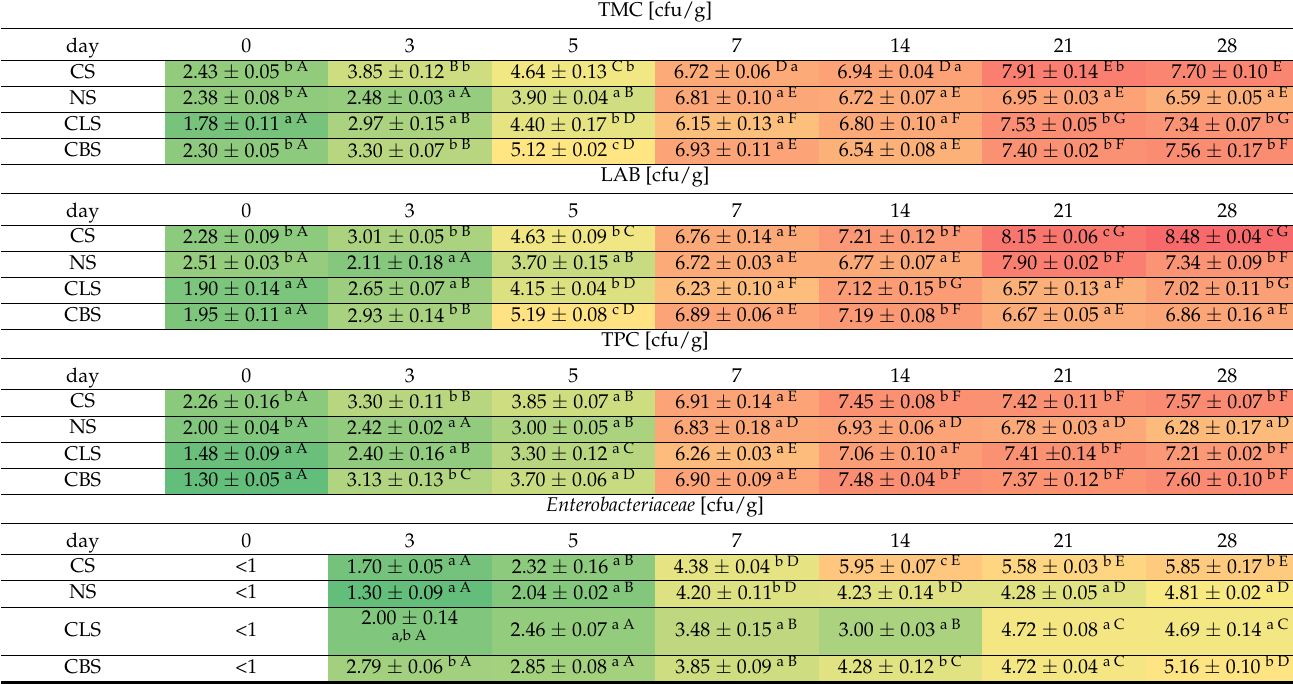
Table 7. Effect of C. incanus extract with lycopene and betanin on the microbiological quality of pork sausages (n =